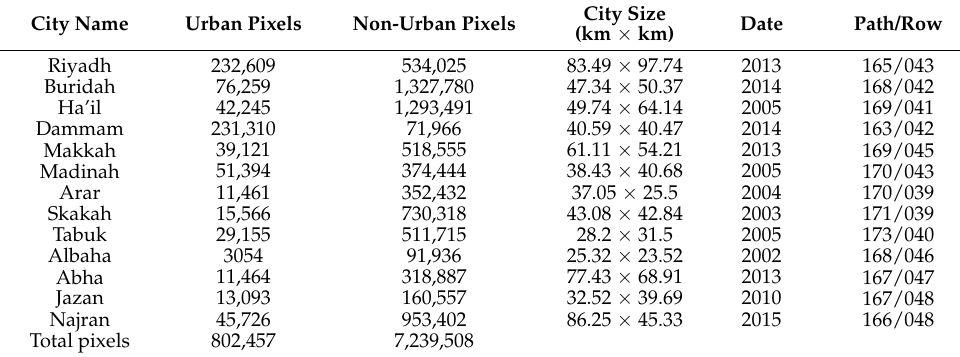
Table 1. Collected training data from the 13